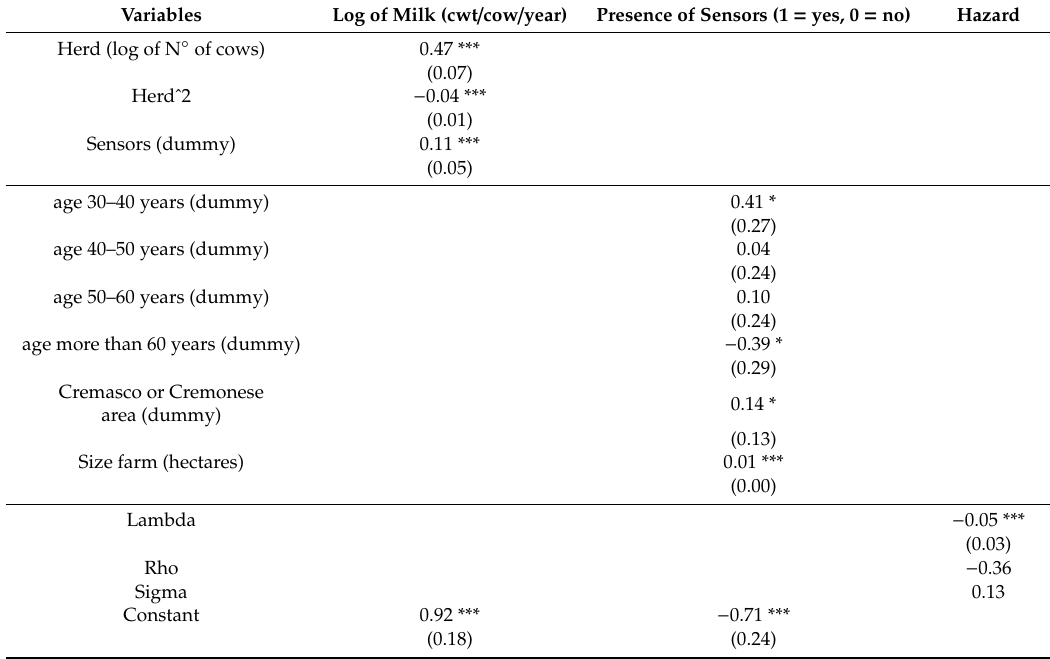
Table 3. Results of two stage treatment regression